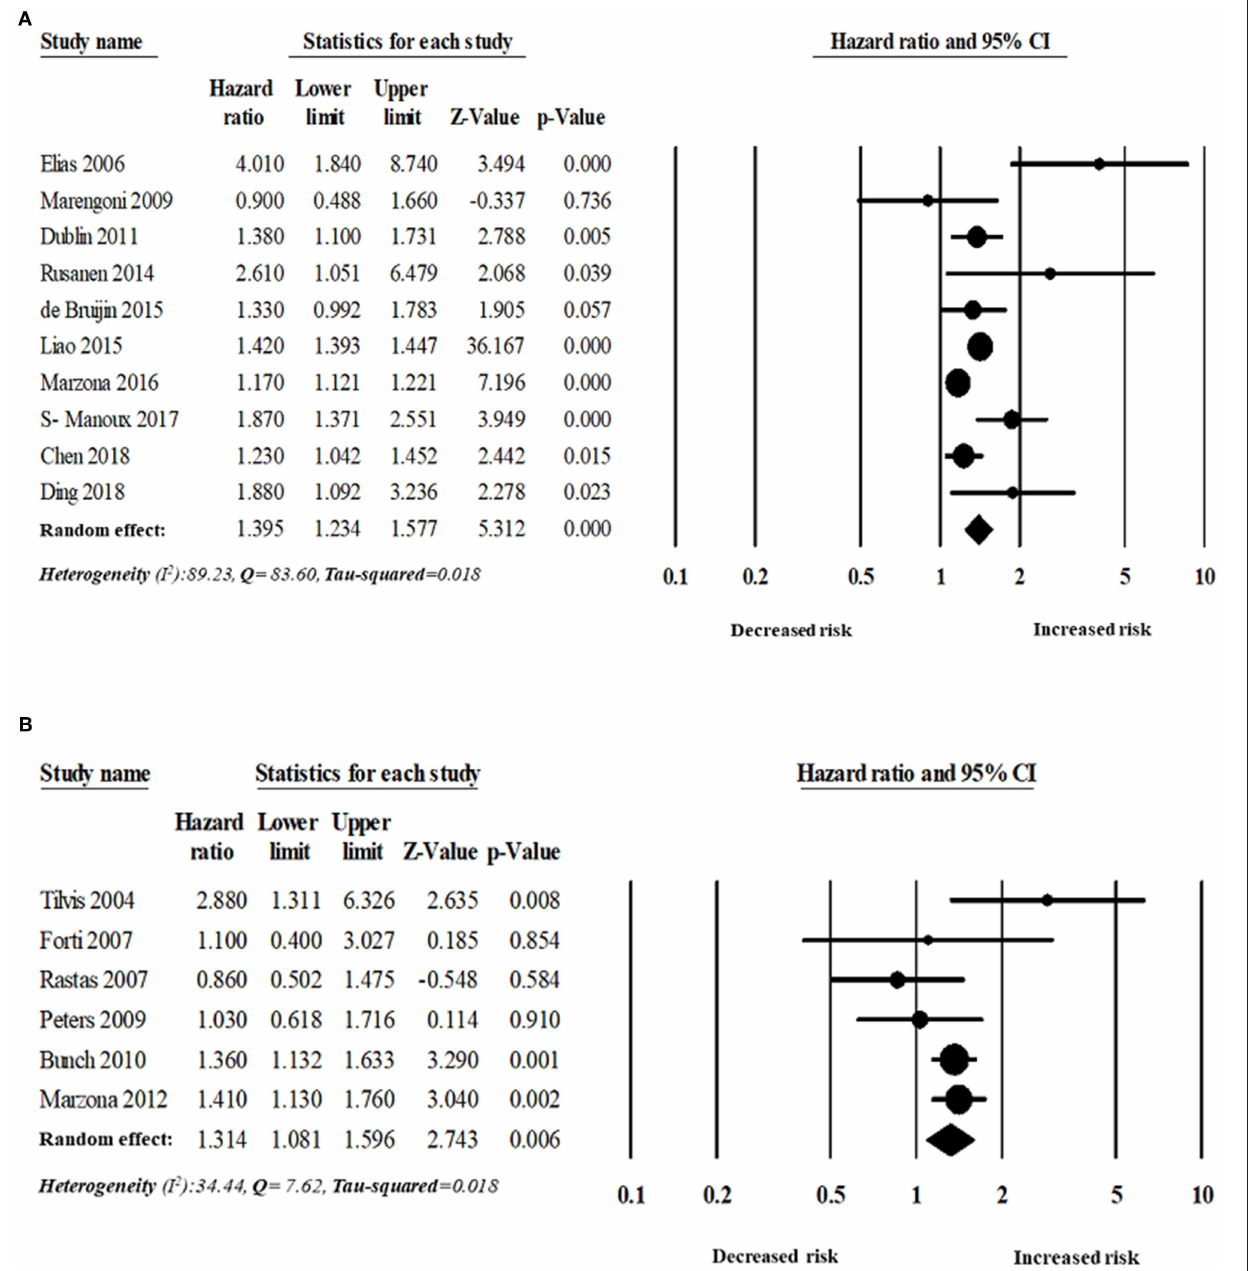
FIGURE 5 | Risk of dementia in patients with AF based on follow-up period: (A) more than five years’ follow-up period, (B) < 5 years’ follow-up